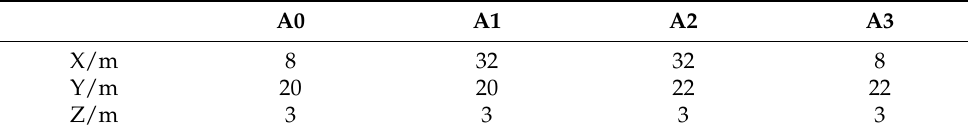
Table 2. Base station coordinates in a corridor simulation space.